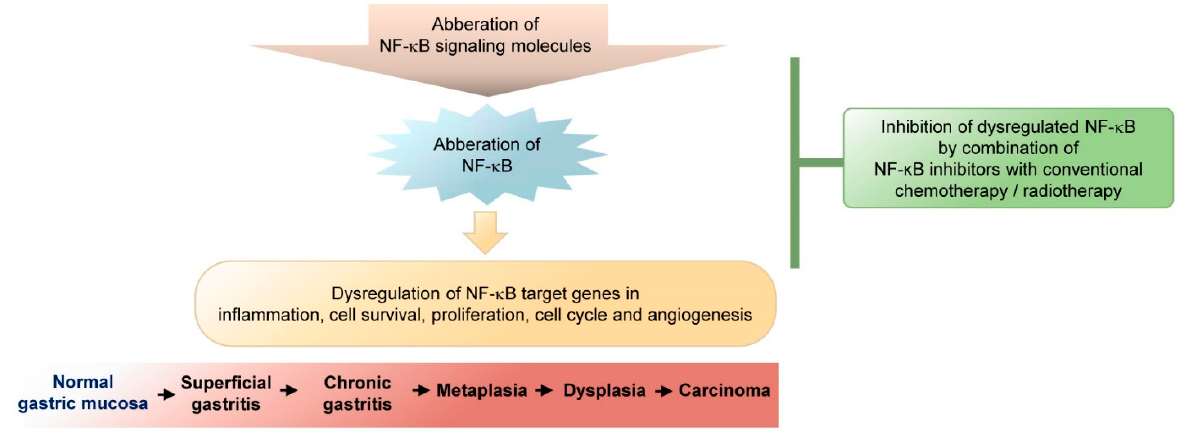
Figure 1. NF- κ B dysregulation in the pathogenesis of gastric cancer. Prerequisites for the progression to gastric carcinoma development could include superficial and chronic gastritis, metaplasia, and dysplasia. The impact of NF- κ B on gastric carcinoma development could be affected by the aberration of NF- κ B signaling molecules or the NF- κ B transcription factors themselves and the dysregulation of NF- κ B target genes. The various NF- κ B target genes are involved in a variety of cellular processes including inflammation, cell survival, proliferation, cell cycle, or angiogenesis. Therapeutic approaches for gastric carcinoma need the development of inhibitors which interfere with the dysregulated NF- κ B system in combination with conventional chemo- or radiotherapy.